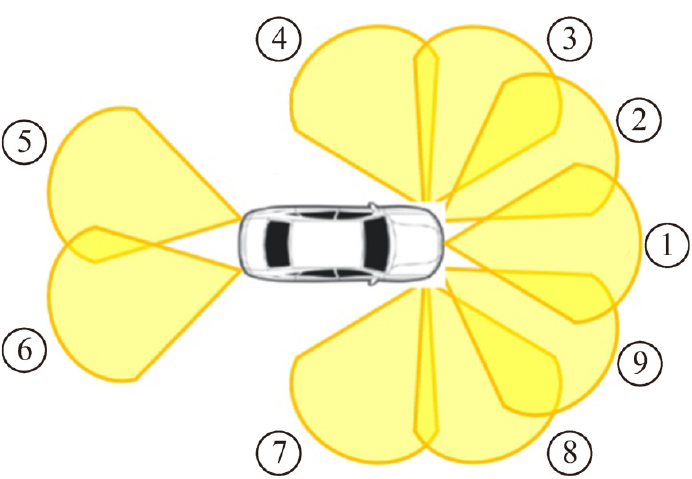
Figure 1. Test Vehicle.